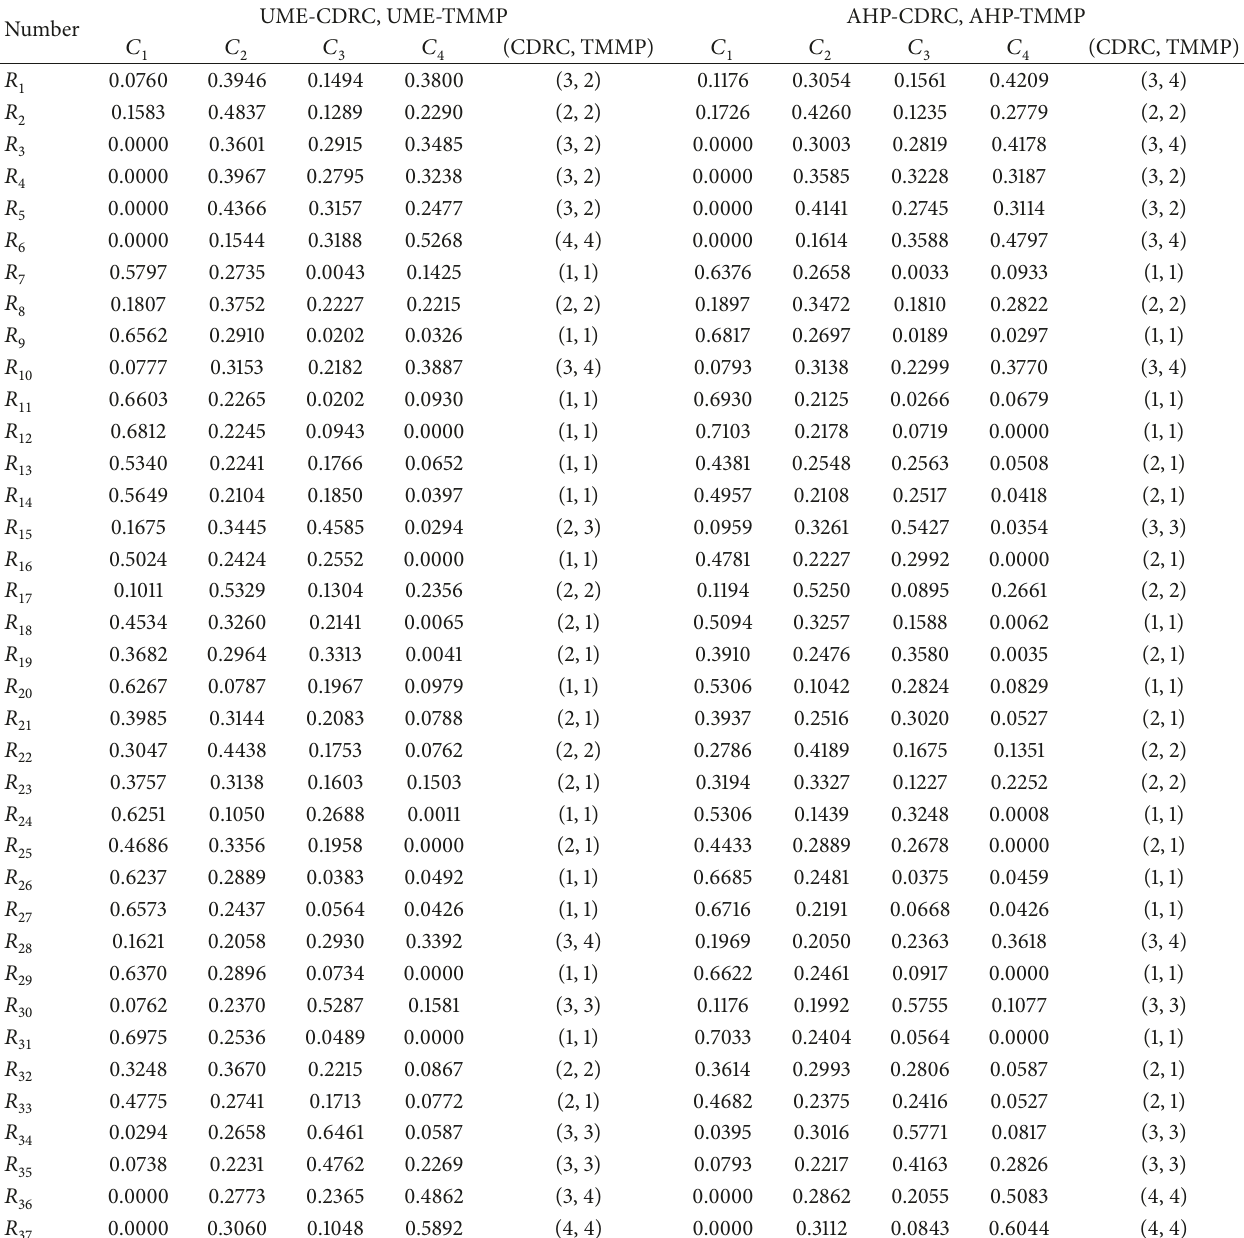
Table 7: The comparison results for UME and AHP of 37 underground goafs, as well as the risk levels evaluated by CDRC and